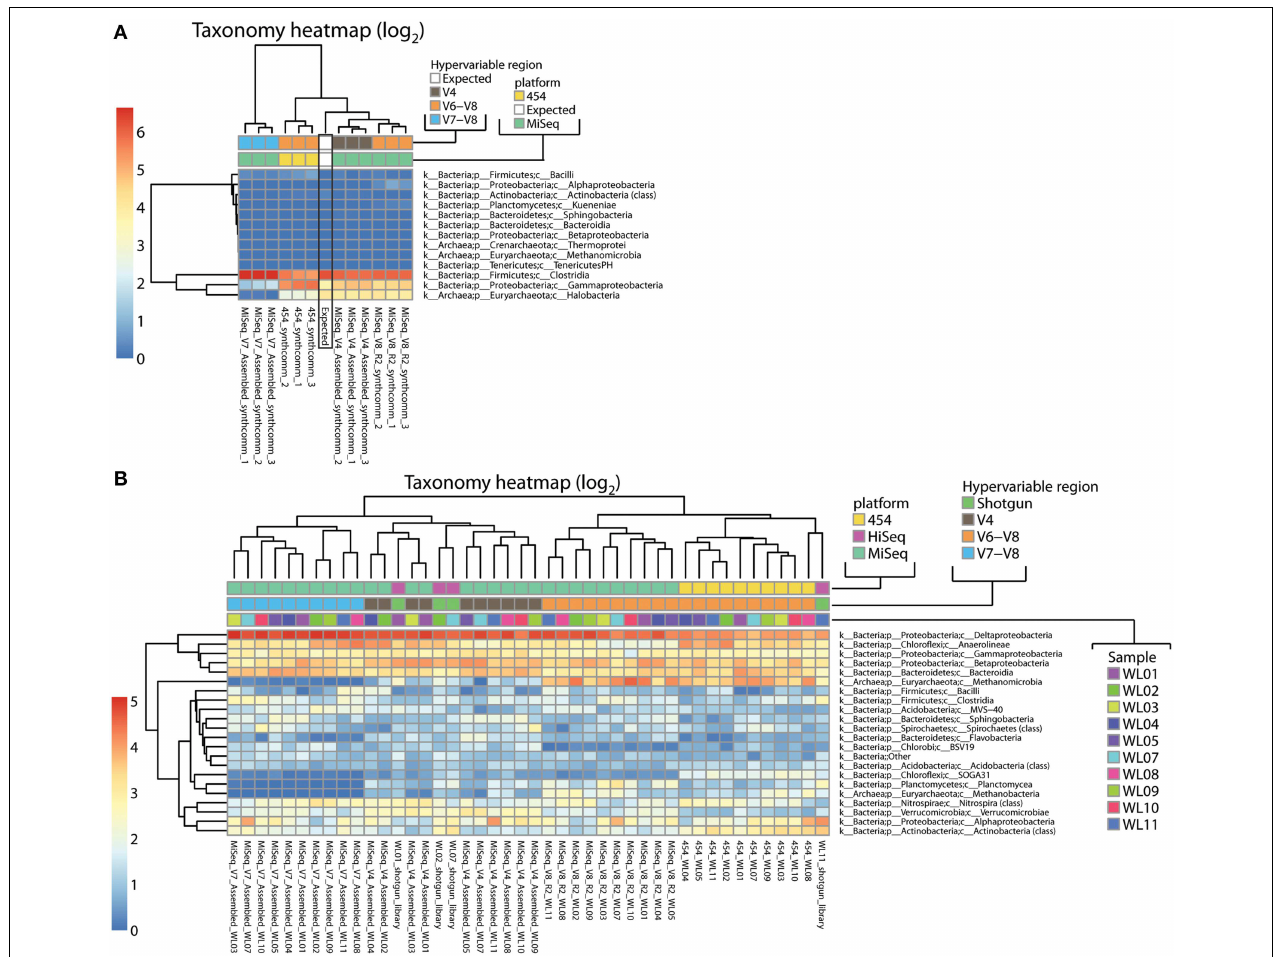
FIGURE 4 | Taxonomy heatmaps of all 16S data from (A) the synthetic community DNA pool and (B) samples from a wetlands sampling site. Color scale is defined as log 2 of percentage values of each